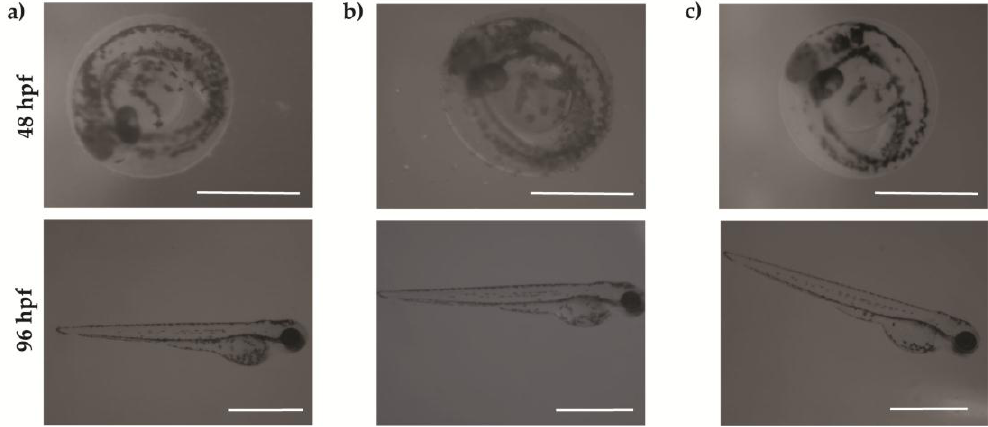
Figure 9. Optical images of embryos at 48 hpf and larvae at 96 hpf treated with 100 µ g · mL − 1 of ( a ) oxi-CNOs; ( b ) oxi-CNHs and ( c ) GO. Scale bar = 1 mm.